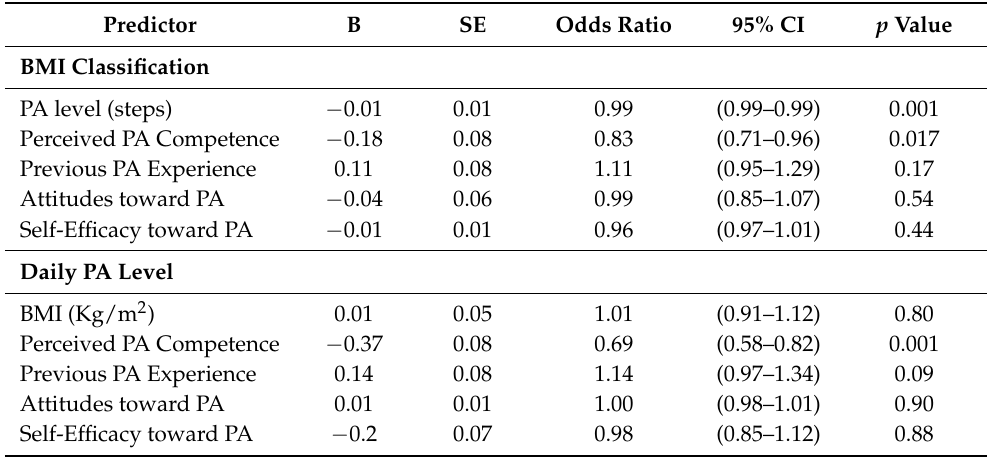
Table 5. Logistic Regression